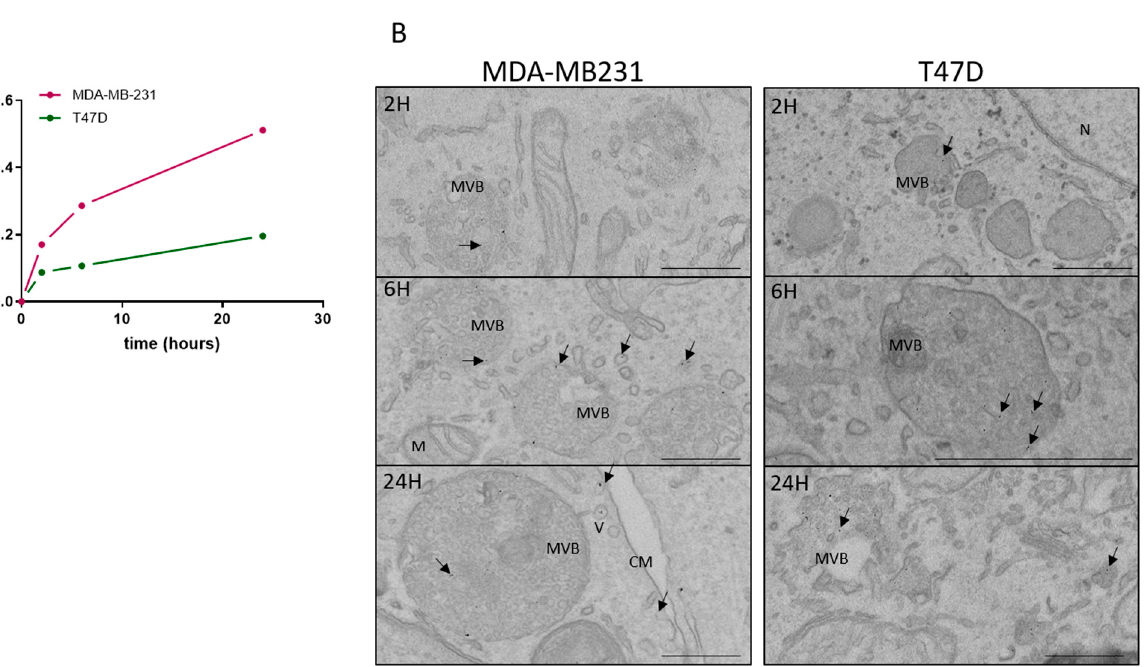
Figure 1. Assessment of the nanoparticle uptake in the MDA-MB-231 and T47D cells. ( A ) Absolute quantification of the intracellular mass of platinum nanoparticles per cell, following an exposure of 2, 6, or 24 h and measured by ICP–MS. ( B ) Representative images obtained by using Transmission Electron Microscopy of the MDA-MB-231 (left) and T47D (right) cells, after being exposed for 2, 6, or 24 h to 0.5 mM PtNPs. Nanoparticles are indicated by arrows. M = mitochondria, MVB = multivesicular body, V = vesicle, CM = cell membrane, N= nucleus. Scale bar = 500 nm.